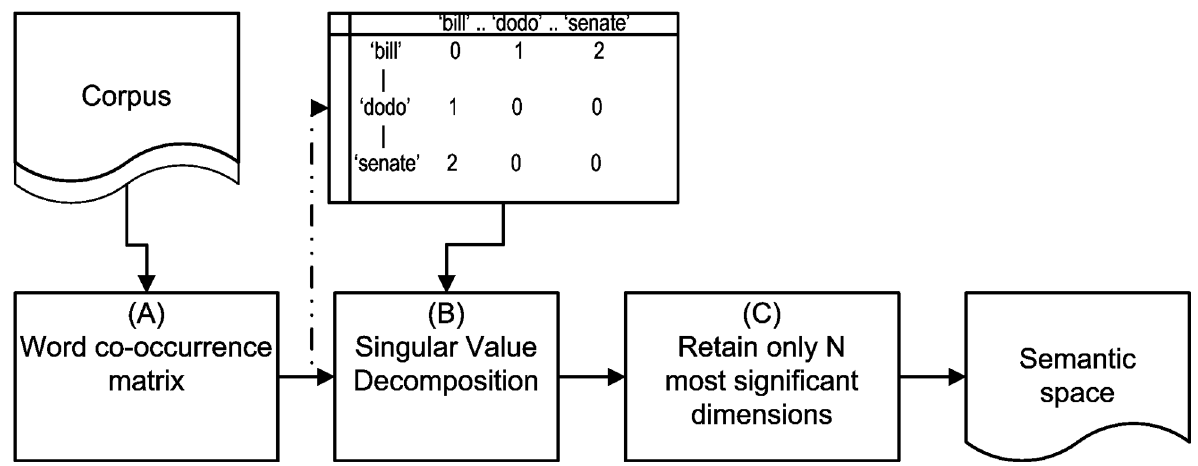
Figure 1. A schematic diagram describing the computation of a semantic space. This figure describes the process of generating a semantic space following the Wordspace paradigm. (A) In the first step an NxM matrix of word co-occurrence is computed. The words for this matrix are chosen based on their frequency of occurrence. (B) Singular Value Decomposition (SVD; a generalized form of factor analysis) is performed on the matrix. This transformation results in a high-dimensional space. (C) Finally, the least significant dimensions of the matrix are dropped so that only the most important, content bearing, dimensions are part of the semantic space. By default, the implementation of Wordspace we used, Infomap, retains 100